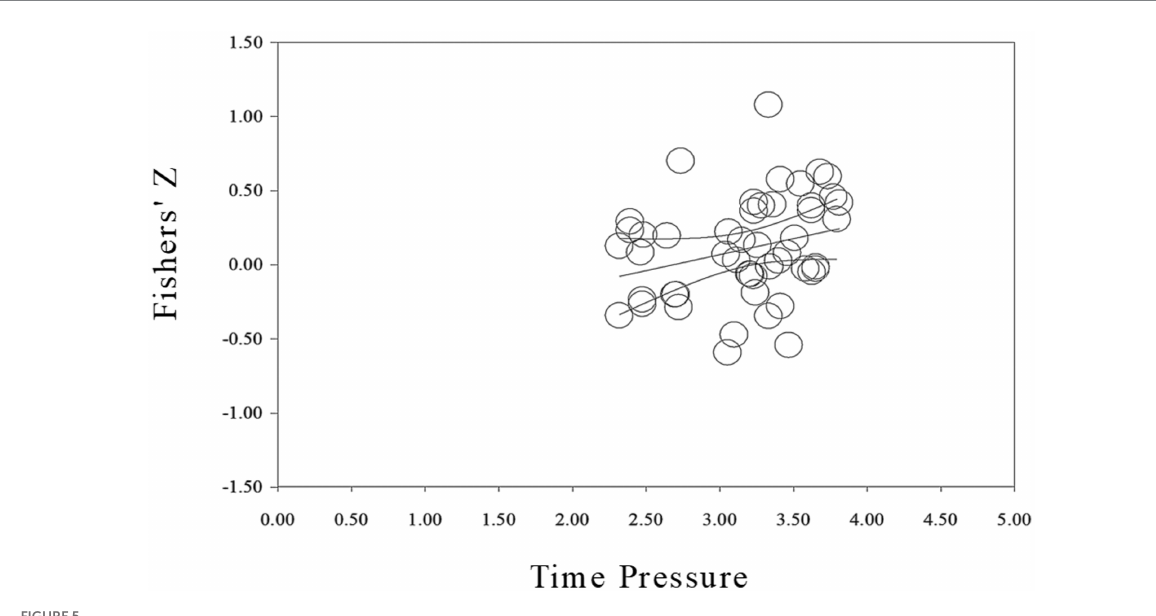
FIGURE 5 Scatter plot of meta-regression analysis.